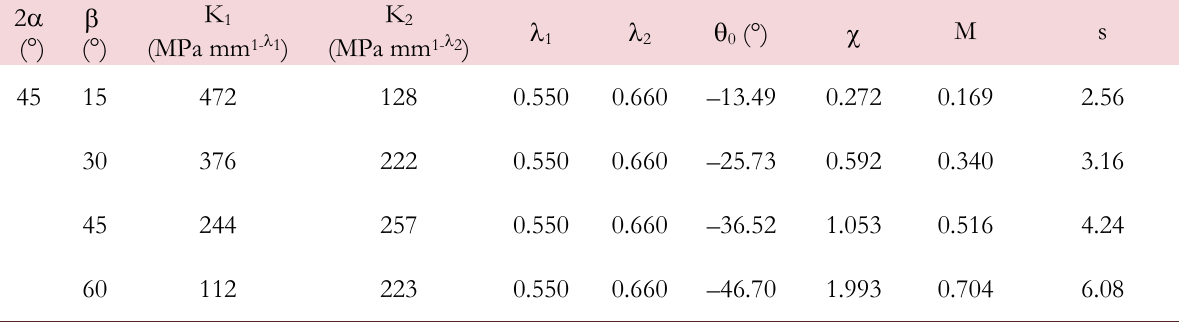
Table 1: Notch stress intensity factors K 1 and K 2 and crack propagation angle  0 for different mode ratios M resulting in support factors